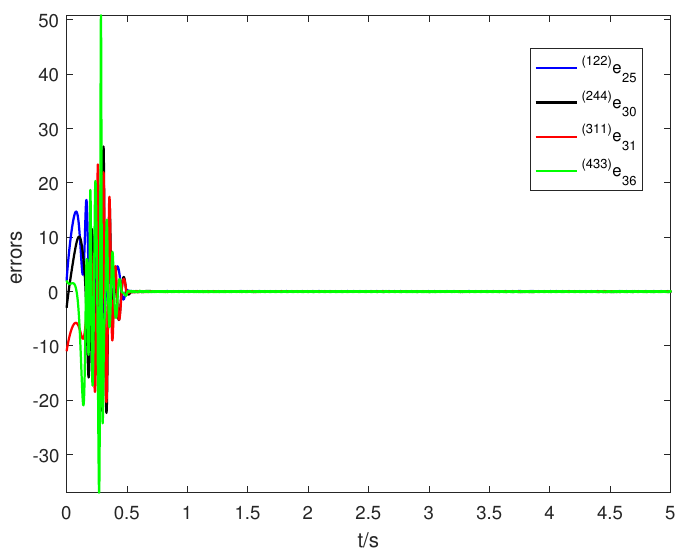
Figure 15. The synchronization errors ( 122 ) e 25 , ( 244 ) e 30 , ( 311 ) e 31 , ( 433 ) e 36 change with time t .